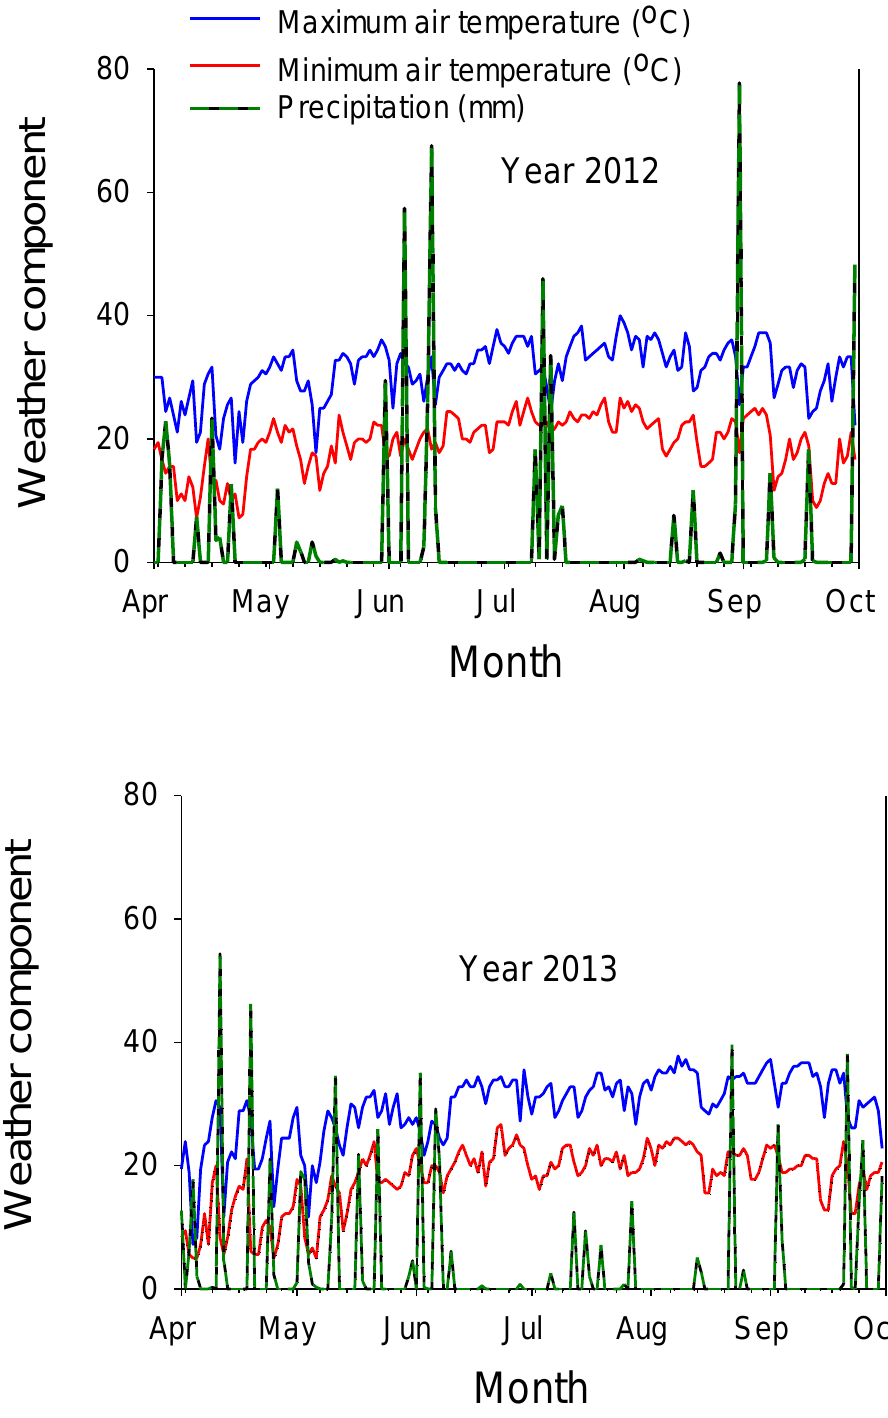
Figure 1. Air temperature (°C) during the growing season in 2012 and 2013. The experiment was conducted in 2012 and 2013 in Stoneville MS. Source: Mississippi State University Extension (2018).